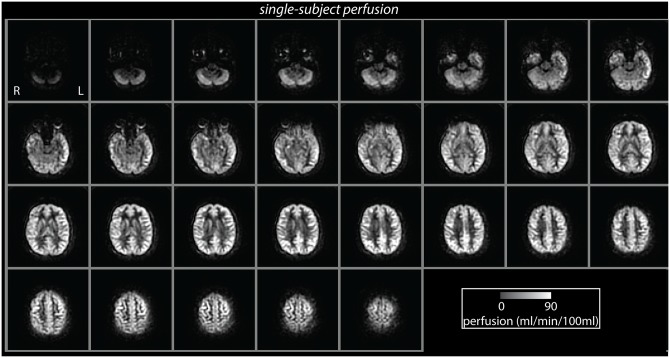
Resting perfusion map acquired from a single participant, shown in radiological orientation (scale: 0–90 ml/min/100ml).